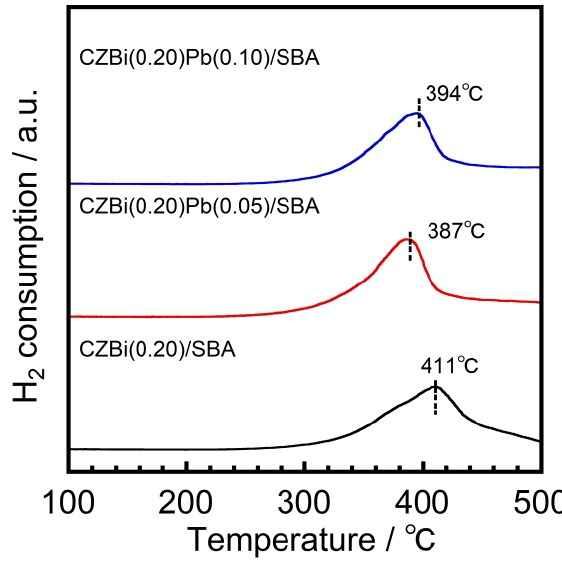
Figure 3. TPR profiles of CZBi(0.20)Pb( x )/SBA. The glycerol oxidation test was performed using Pt/CZBi(0.20)Pb( x )/SBA (0.3 g, glyc- erol/Pt = 10 mol/mol) at 30 °C for 4 h in atmospheric air, and the results are tabulated in Table 1, wherein, MA was not detected. Considering Pt/CZBi(0.20)Pb(0.05)/SBA, the